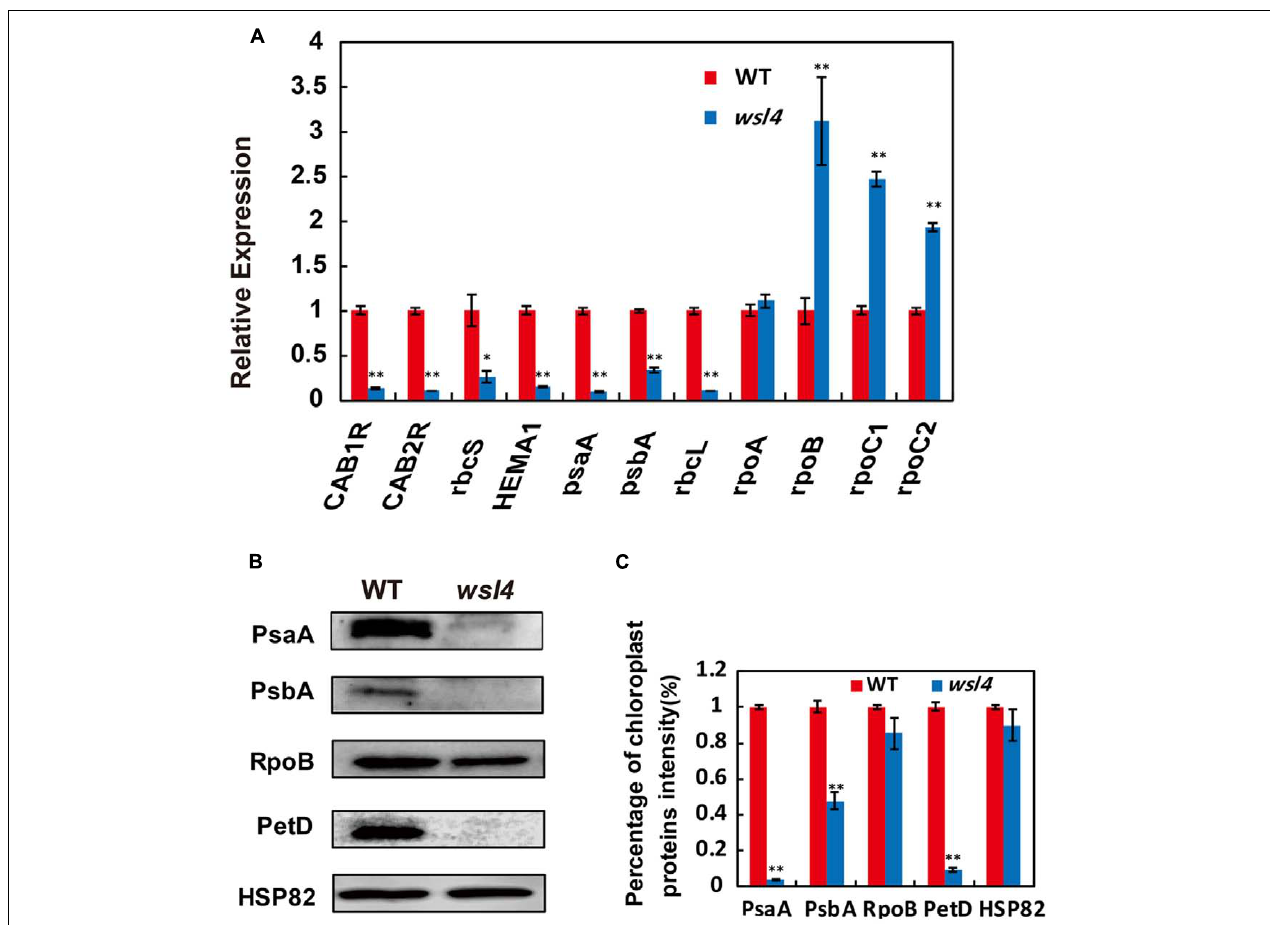
FIGURE 6 | Expression analyses of chloroplast-encoded, and nuclear-encoded genes as well as immunoblot analyses of plastidic proteins. (A) qRT-PCR analyses of genes associated with chloroplast development in WT and wsl4 . Total RNA was extracted from L3-3 of the corresponding plants grown in a growth chamber at L30/D25. (B) Immunoblot analyses of photosynthetic proteins in WT and the wsl4 mutant. Total proteins were extracted from L3-3 of WT and wsl4 mutant plants grown in a growth chamber at L30/D25. L3-3 indicates the third leaf at the three-leaf stage. HSP82 was used as an internal control. (C) Quantification of the band intensity of photosynthetic proteins in the wsl4 mutant compared- to WT corresponding to (B) . Values are means ± SD of three replicates. Student’s t -test: ∗ P < 0.05, ∗∗ P <